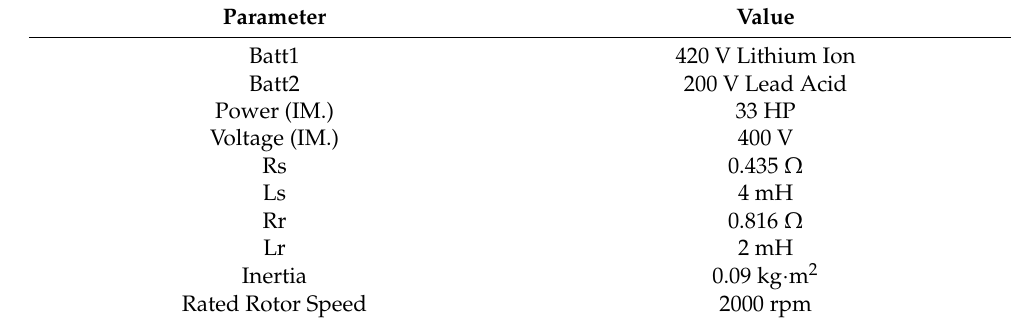
Table 1. Simulation specification.